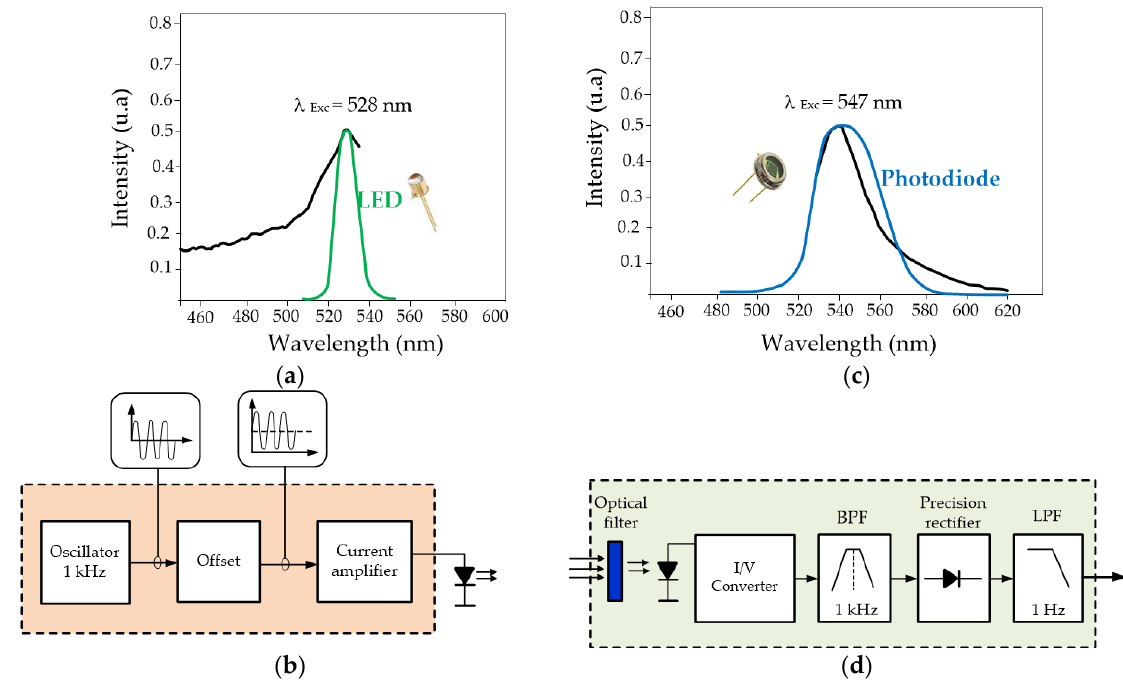
Figure 16. ( a ) Excitation spectrum of the chemical sensor and LED. ( b ) Optical sensor and photodiode emission spectra. ( c ) Block diagram of the light source. ( d ) Block diagram of the light detector.